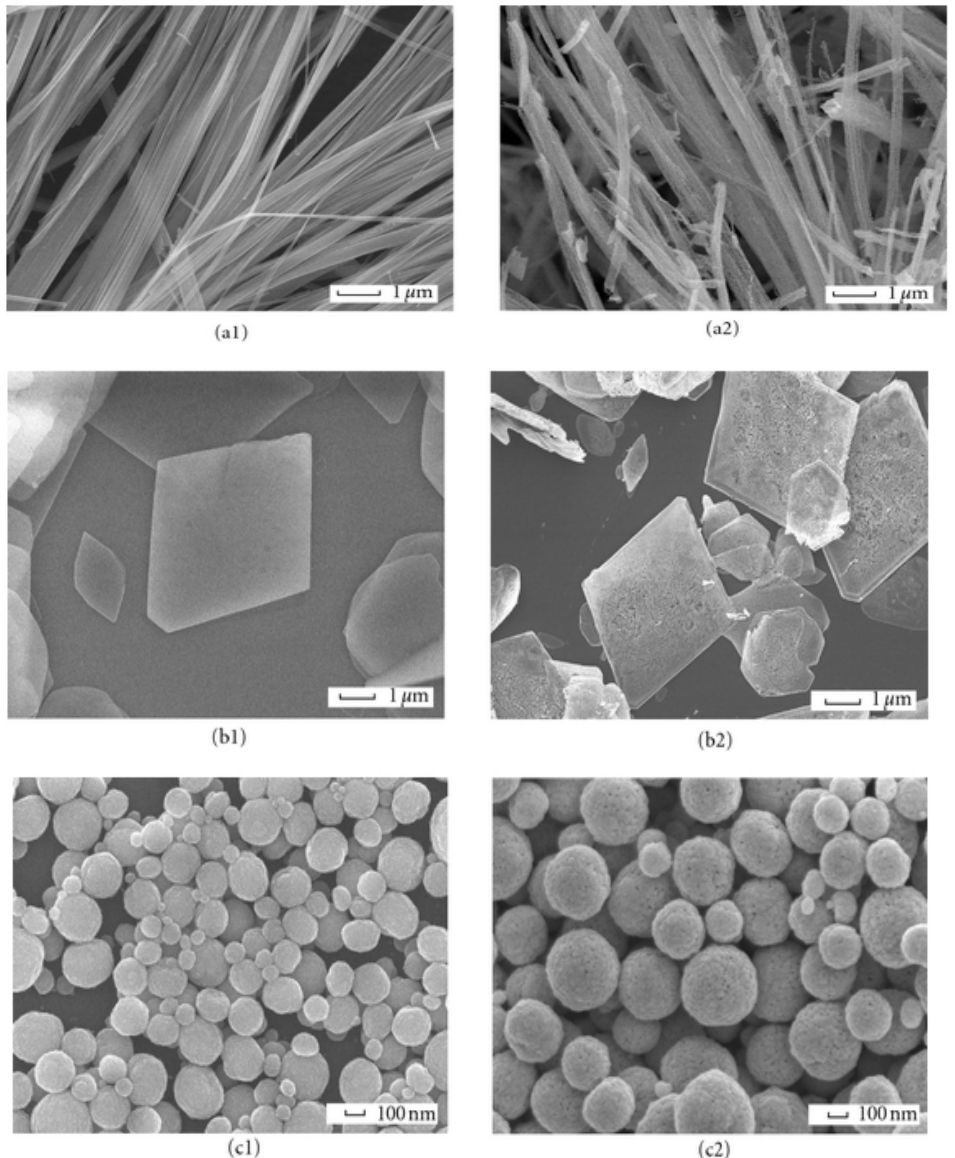
Figure 7. SEM images of different ZnO nanstructures obtained with different glycol solvents and heated at 160 °C (1) and calcined at 500 °C (2): ( a1 , a2 ) ethylene glycol, ( b1 , b2 ), glycerol and ( c1 , c2 ) diethylene glycol solvents. Adapted from [90].